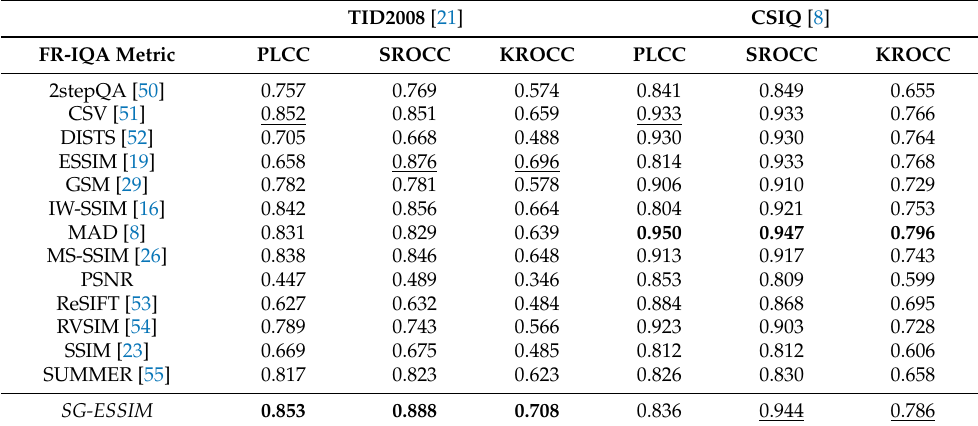
Table 4. Comparison of SG-ESSIM to several other state-of-the-art algorithms on TID2008 [21] and CSIQ [8]. The highest values are typed in bold , while the second highest ones are underlined.